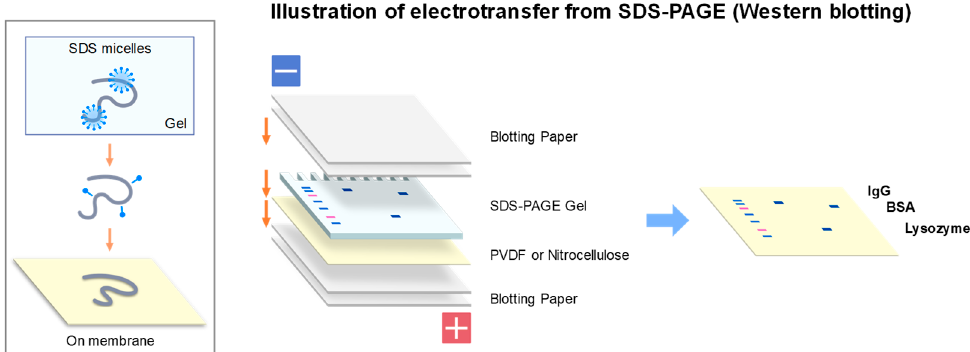
Figure 7. Schematic illustration of electroblotting from SDS-PAGE (original western blotting). SDS micelles bind to a polypeptide chain (inset, top) and may at least partially dissociate during transfer process (middle) and fully dissociate upon transfer to the membrane (bottom). Normal setup of electroblotting of SDS-PAGE gel is depicted in right side. Typical condition of blotting (semi-dry) was at a constant current of 1.5 mA/cm 2 for 30 min.